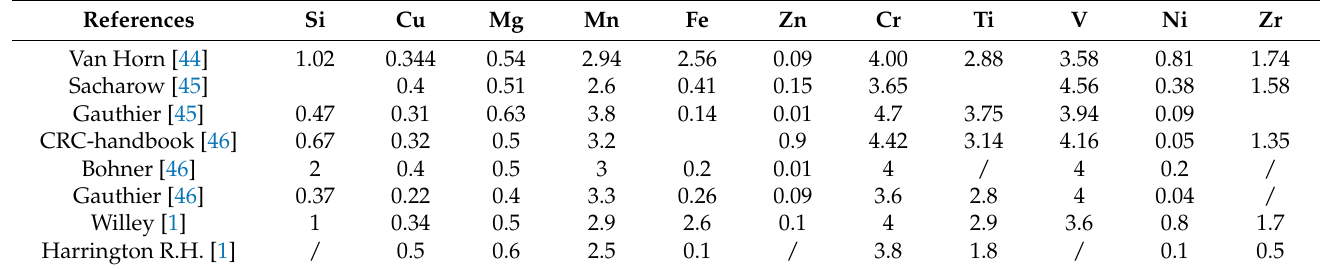
Table 2. Increments in resistivity of pure aluminum per 1% alloying elements in a solid solution ( µ Ω